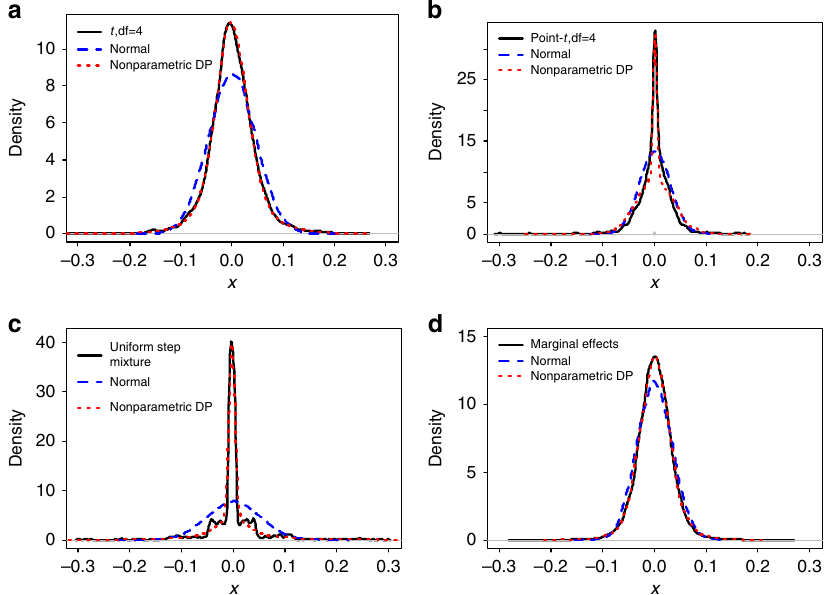
Fig. 1 The induced non-parametric Dirichlet process (nonparametric DP) normal mixture prior on the effect sizes can be used to approximate a large number of unimodal distributions. We either simulated 2000 values from a a standard t-distribution with df = 4; b a point-t mixture distribution with the zero proportion being 0.2, or equivalently, 0.8 × t (df = 4) + 0.2 × δ 0 , where δ 0 denotes a point mass at zero; c a four-component uniform step mixture distribution 0.50 × U ( − 0.05,0.05) + 0.25 × U ( − 0.3,0.3) + 0.15 × U ( − 0.8,0.8) + 0.05 × U ( − 2,2), where U denotes a uniform distribution; or obtained d the estimated marginal effect sizes from a linear mixed model in the cattle data with SCS (somatic cell score) as the phenotype. To make the fi rst three data comparable with the last data in d , we centered and scaled the values from the fi rst three data for them to have a mean of zero and within the range of ( − 0.3,0.3). We then fi t each data with either our non-parametric distribution ( red ) or a normal distribution ( blue ), and displayed the fi tted curves on top of the sample distribution ( black ). Clearly, the non-parametric Dirichlet process normal mixture can approximate all these distributions well, while a